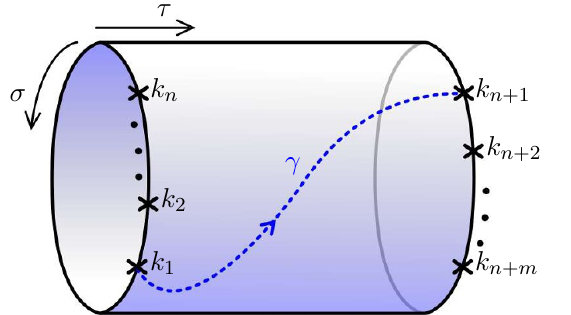
Figure 8 . In AdS/CFT the double trace amplitude is mapped to a worldsheet amplitude in AdS 5 (cid:2) S 5 . The worldsheet has cylindrical topology and ends on an IR D3 brane close to the Poincar(cid:19)e horizon. It has n ordered gluon vertex operators on one boundary, (4.1), and m on the other, (4.2). Here, the cut (cid:13) is a curve on the worldsheet that starts at (cid:27) 1 on the left boundary, crosses the cylinder and ends at _ (cid:27) 1 on the right